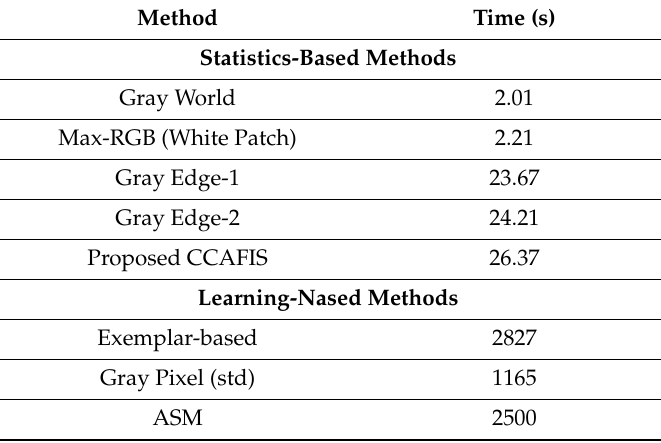
Table 7. Cumulative execution time for the first 100 images of the Colour Checker benchmark image dataset for the proposed CCAFIS, statistical-based and learning-based colour constancy adjustment